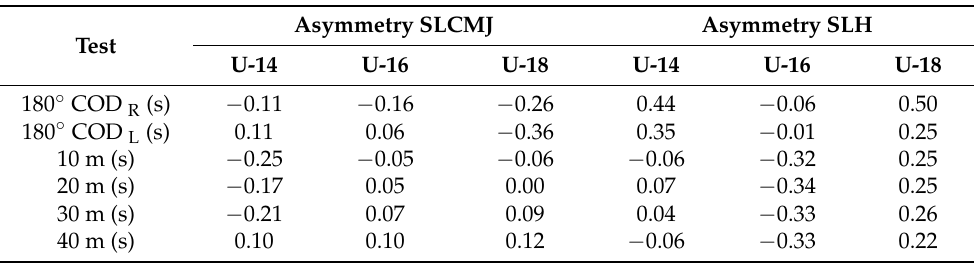
Table 4. Spearman’s ρ correlation between vertical and horizontal jump height asymmetry and test across age groups.